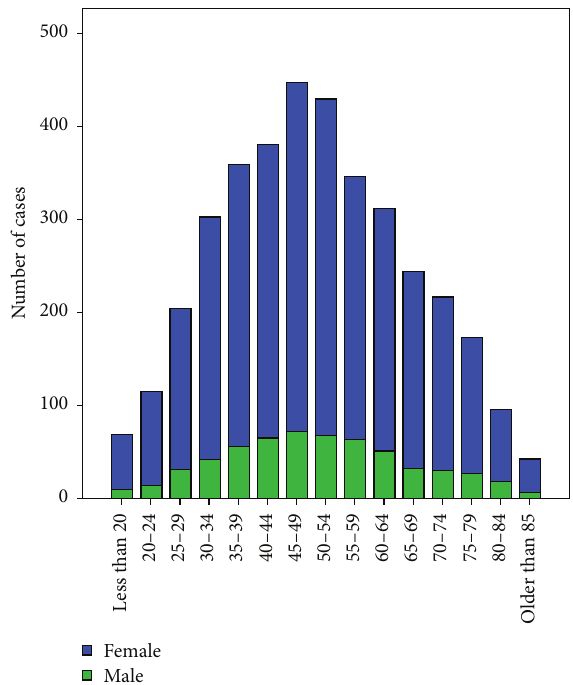
Figure 1: Age distribution of patients with Graves’ disease.